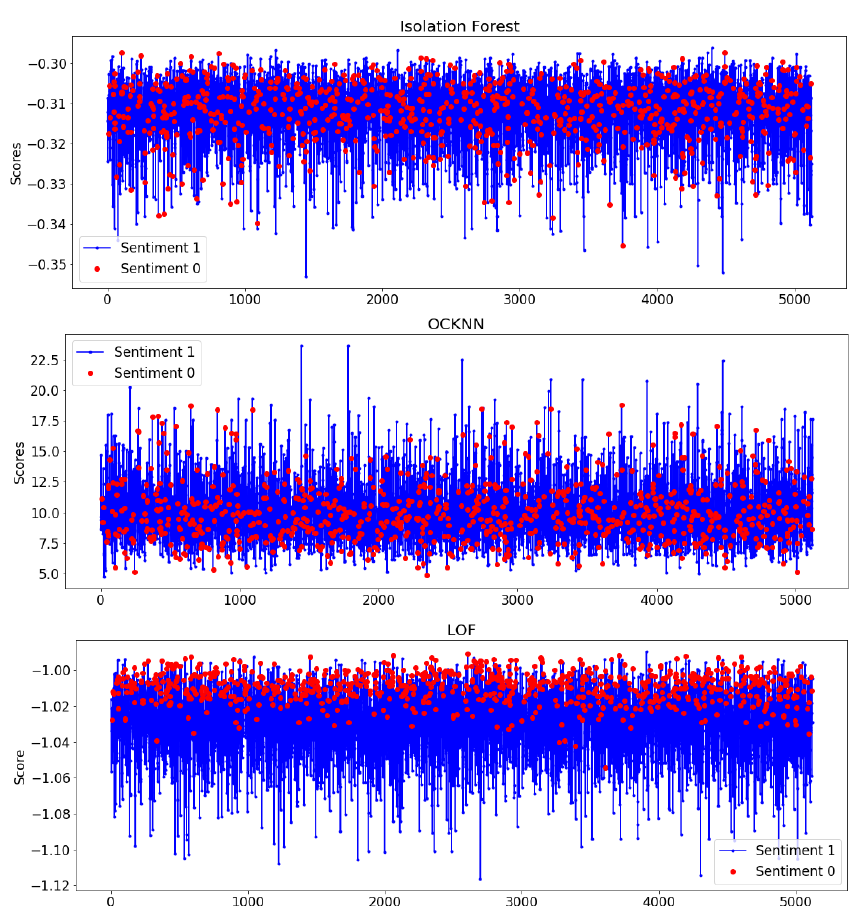
Figure 10. Anomaly scores distinguishing sentiment 1 from sentiment 0. First graphic represents the Isolation Forest results, second shows OCKNN results, and third shows LOF results. The y -axis represents the scores and the x -axis represents the sample